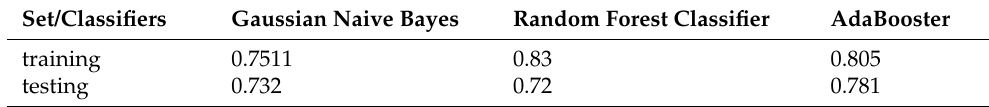
Table 5. Kernels in cascaded SVC and BMI super groups.